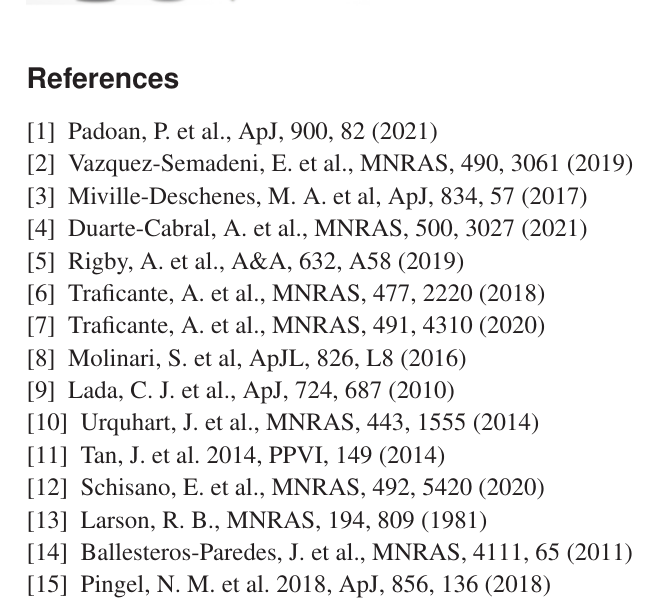
Figure 2. Cartoon representation of the interplay between gravity and turbulence in star-forming regions. A cloud begins to be compressed due to the e ff ect of the strong interstellar medium turbulence, with a minimal contribution from gravity. As the material starts to accumulate in di ff erent eddies due to turbulence, these regions increase their surface density and with it the role of gravity in driving the motions. As the density reaches the critical value of . 1 g cm − 2 , the motions induced by gravity dominate Σ th = 0 over the turbulence, which, from this point, becomes sub-dominant